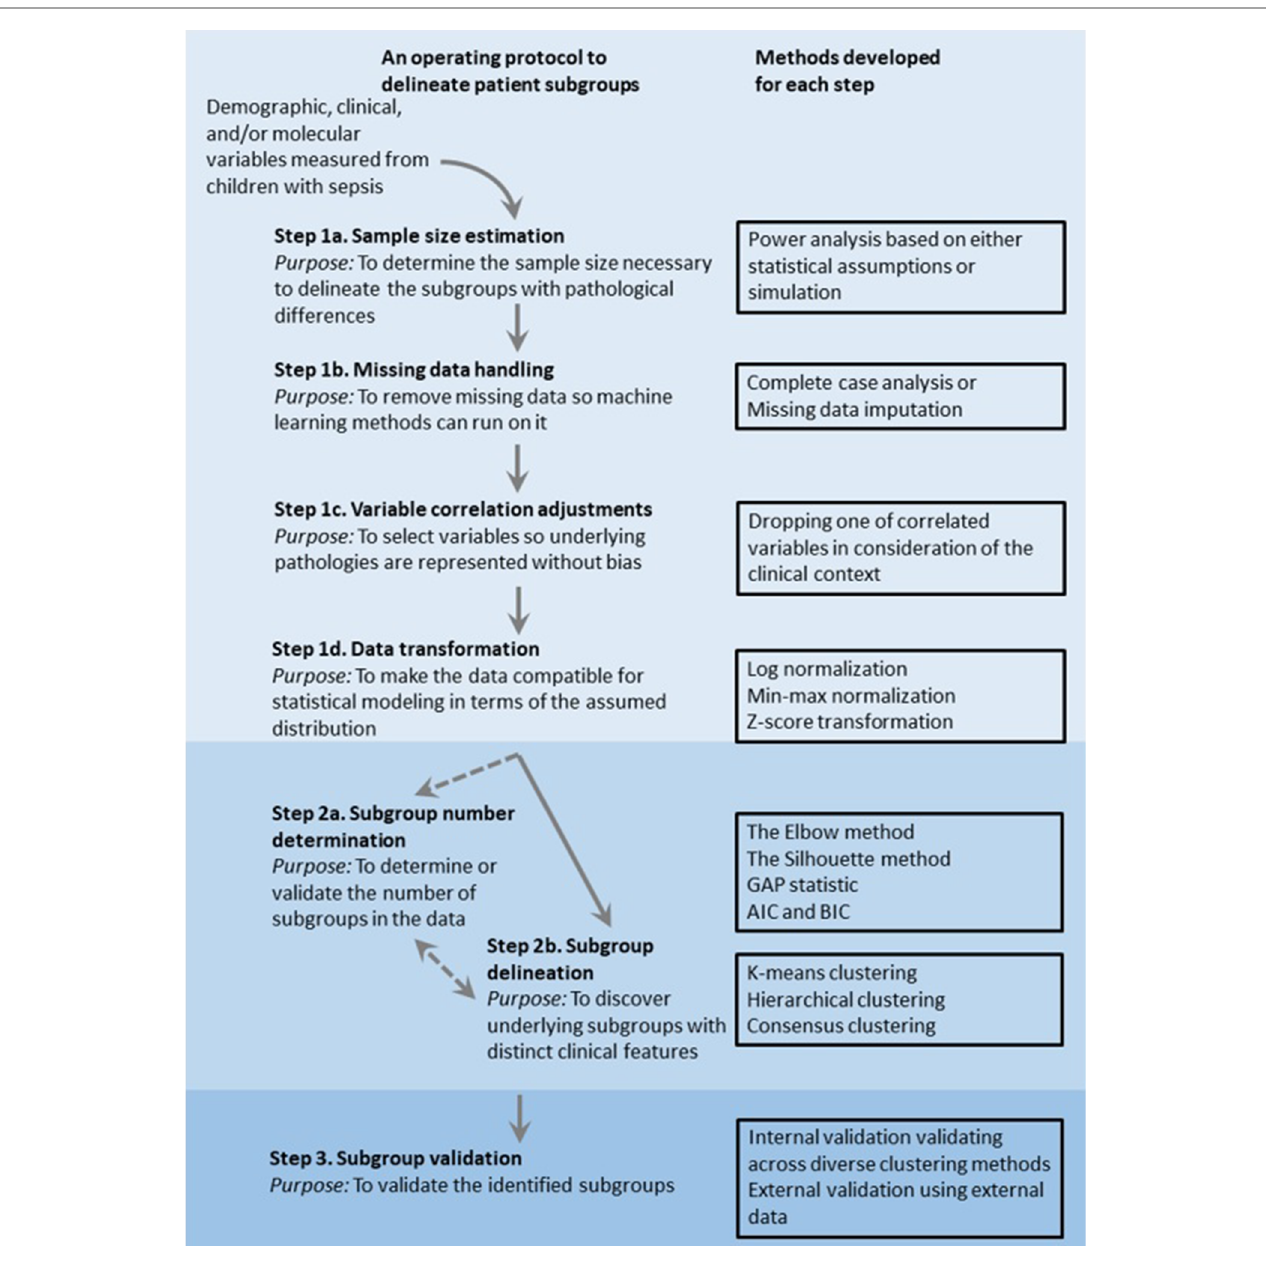
FIGURE 1 Overview of an operating protocol to delineate patient subgroups using observational data of clinical